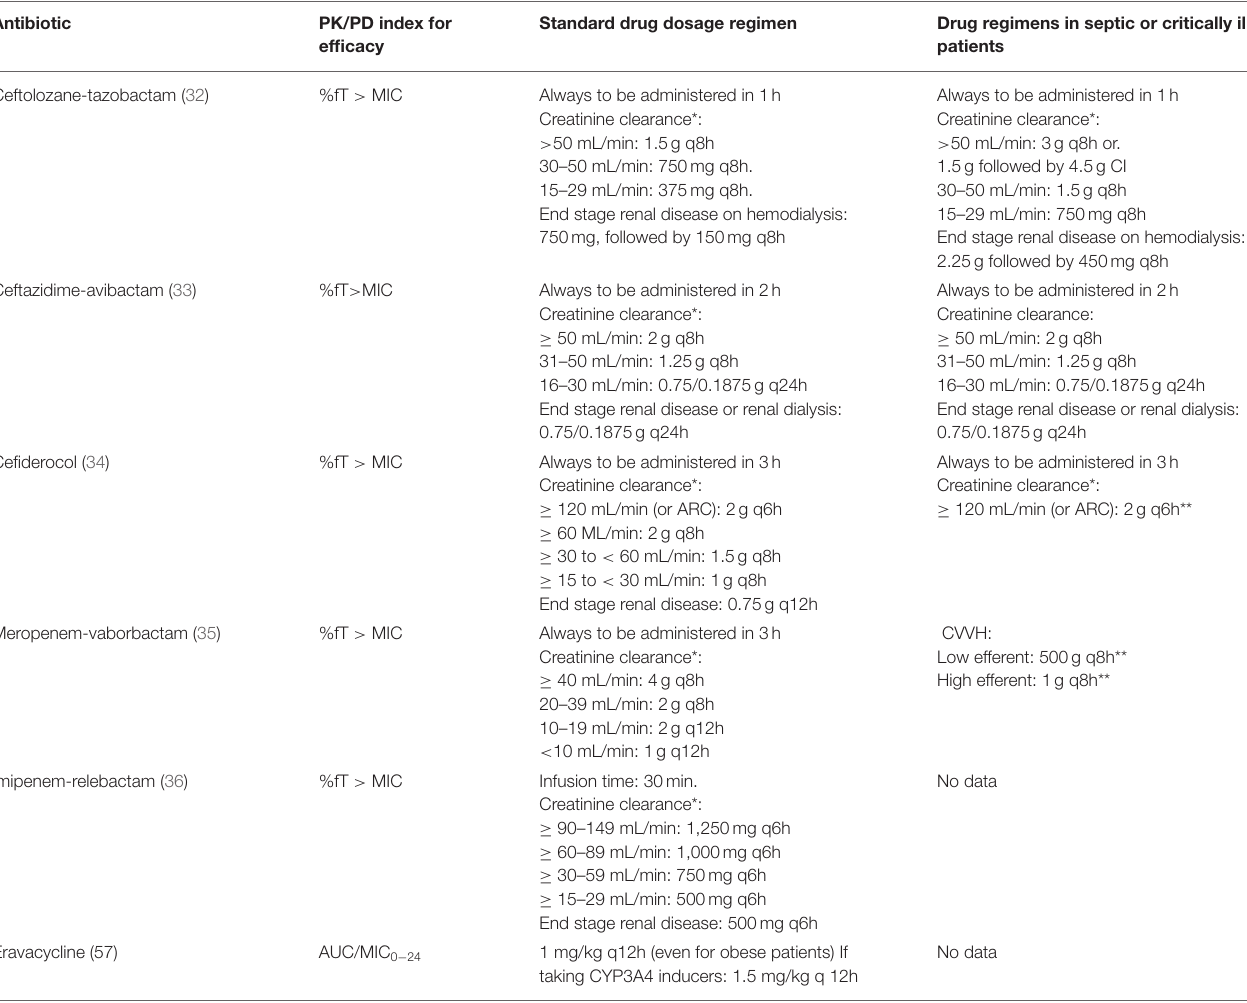
TABLE 1 | PK/PD indexes and drug dosage regimens in adults of these novel antibiotics.